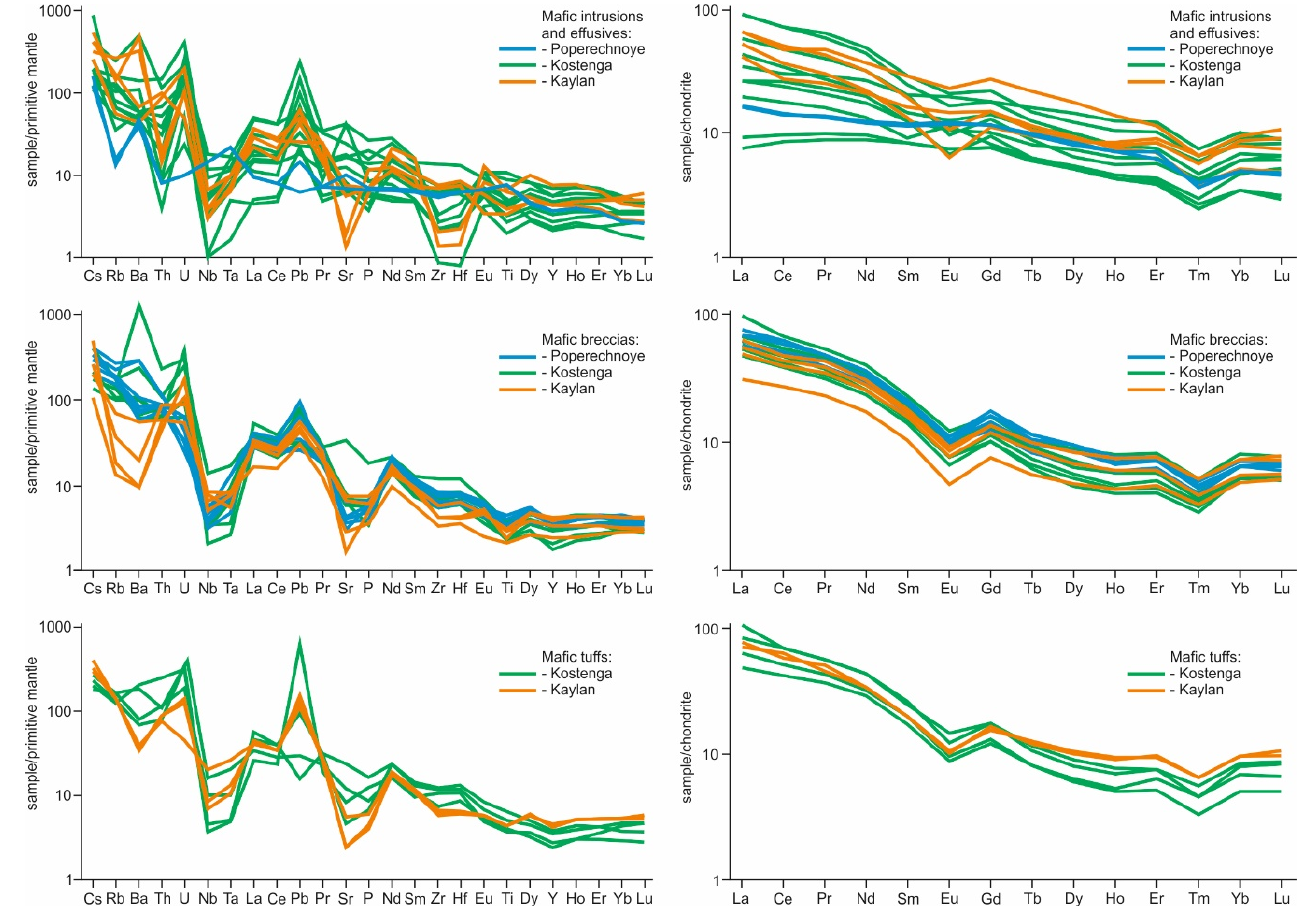
Figure 6. Primitive mantle-normalized [69] trace element ( left column ) and chondrite-normalized [69] rare earth element ( right column ) patterns for the volcanic rocks associated with the LKR iron-oxide deposits.